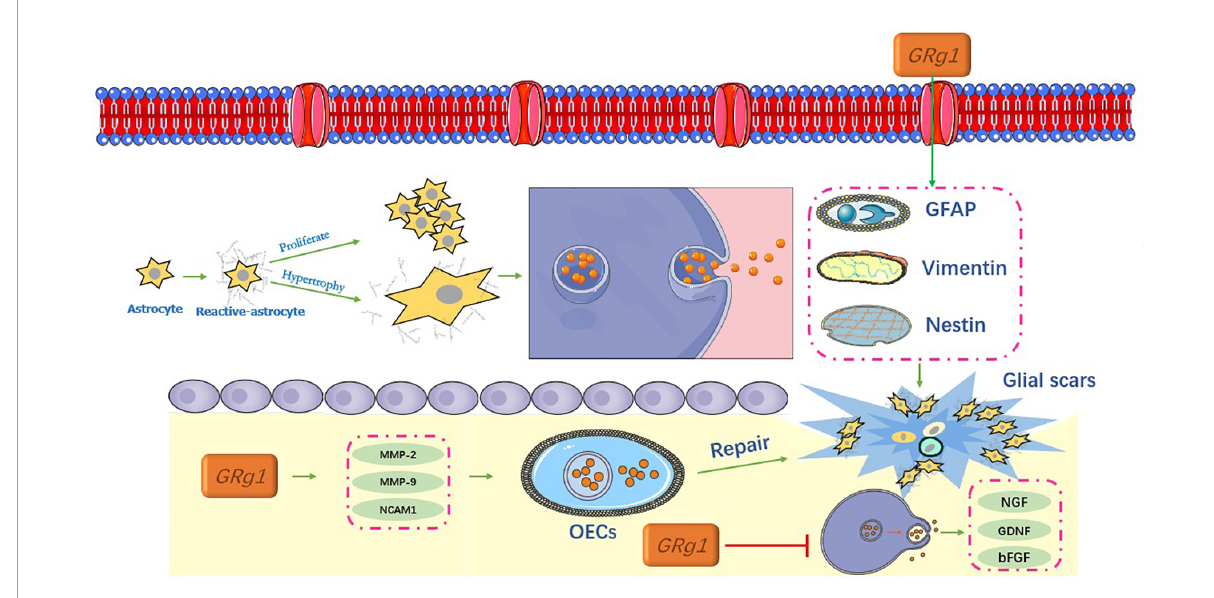
FIGURE5 Inhibition of glial scar formation by